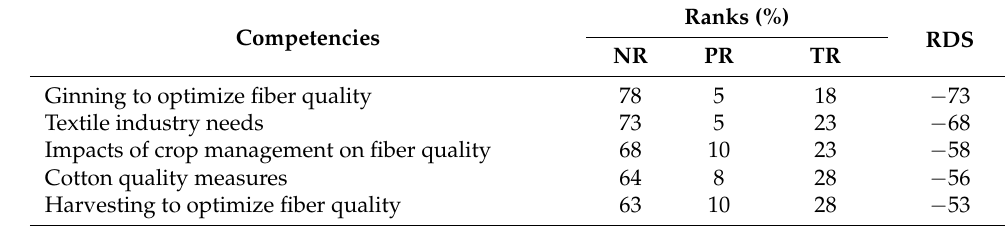
Table 6. Ranked Discrepancy Scores for individual competencies in fiber quality and post-harvest. Competencies